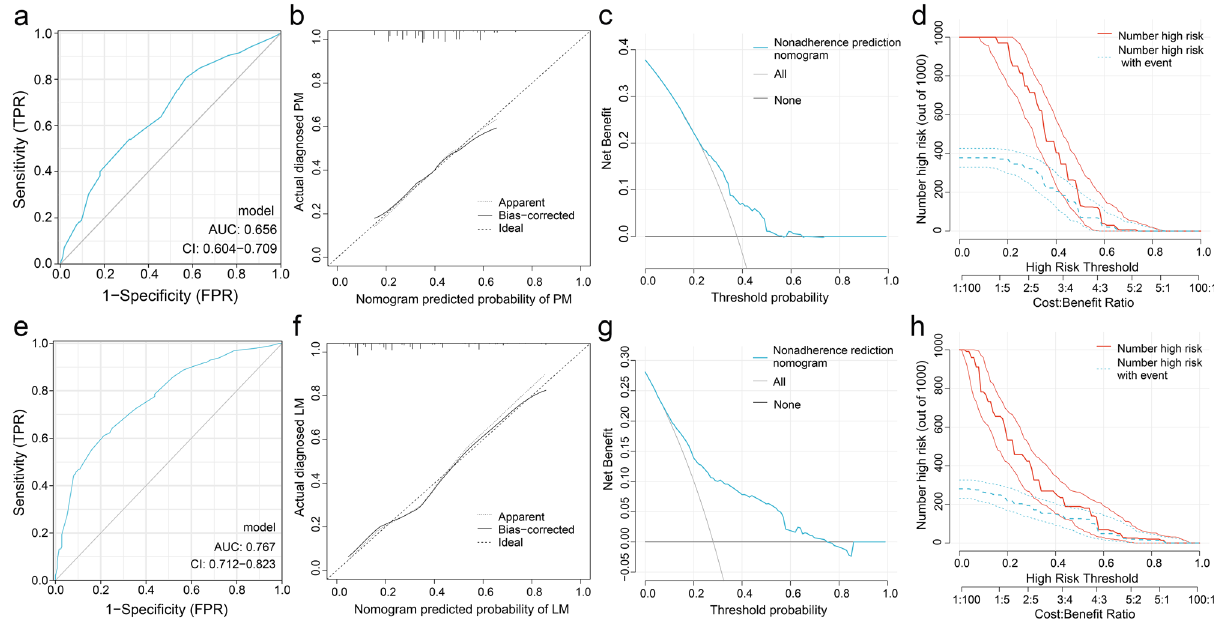
Figure 7. Receiver operating characteristic (ROC) curves ( a , e ), calibration curves ( b , f ), decision curve analysis (DCA, c , g ) and clinical impact plots of nomogram ( d , h ) for predicting PM and